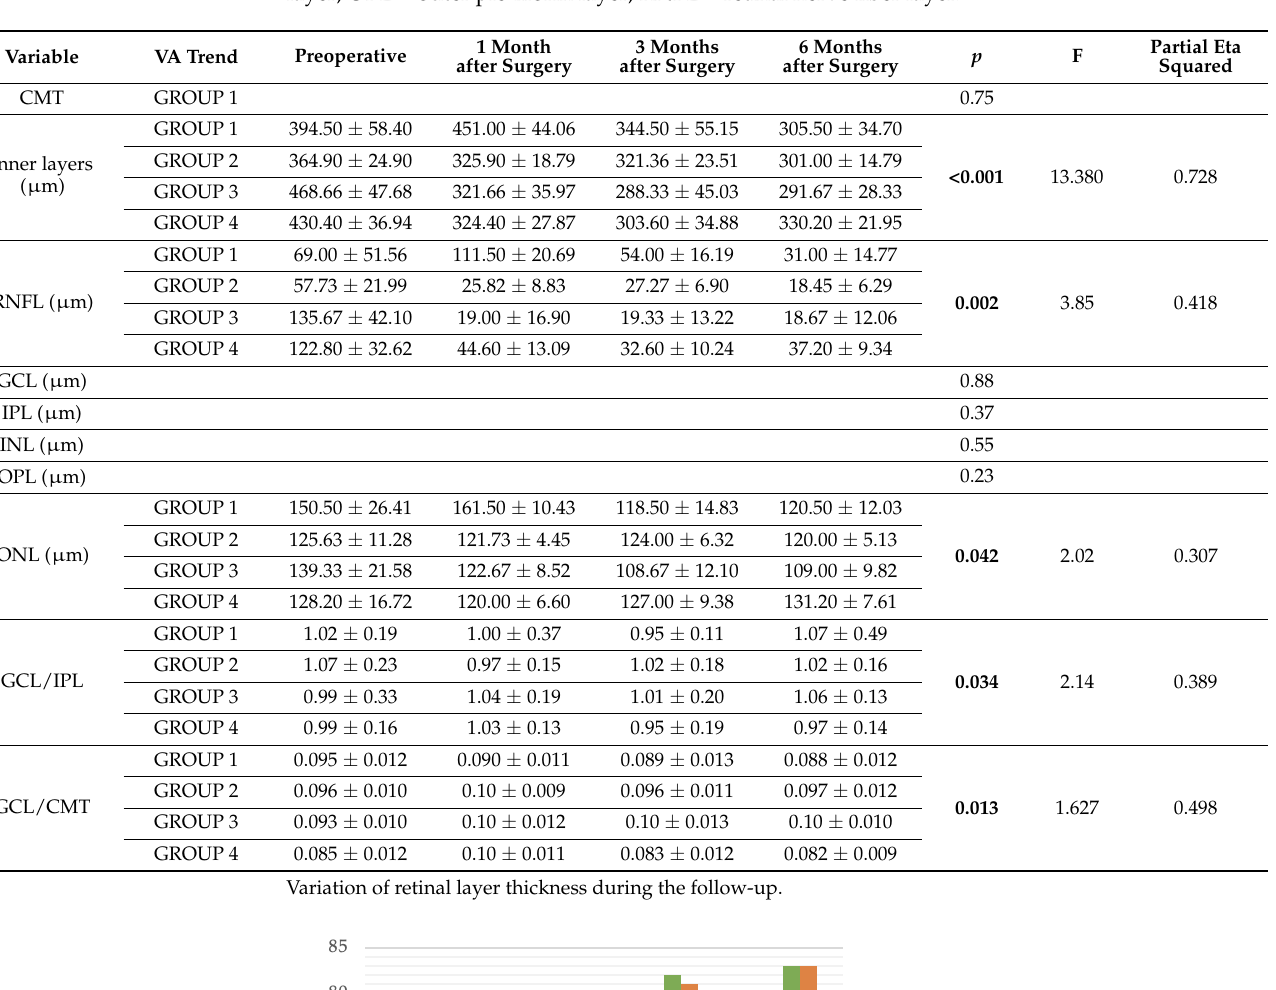
Table 2. Differences in variation of retinal layer thicknesses for each follow-up according to VA trend. Results for two-way ANCOVA for repeated measures are displayed. CMT = central macular thickness; GCL = ganglion cell layer; INL = inner nuclear layer; IPL = inner plexiform layer; ONL = outer nuclear layer; OPL = outer plexiform layer; RNFL = retinal nerve fiber layer.